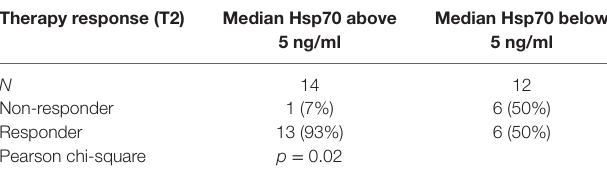
Table 5 | Comparison of post- (T2) therapeutic heat shock protein 70 (Hsp70) plasma levels in non-responding and responding non-small-cell lung cancer patients (M0).